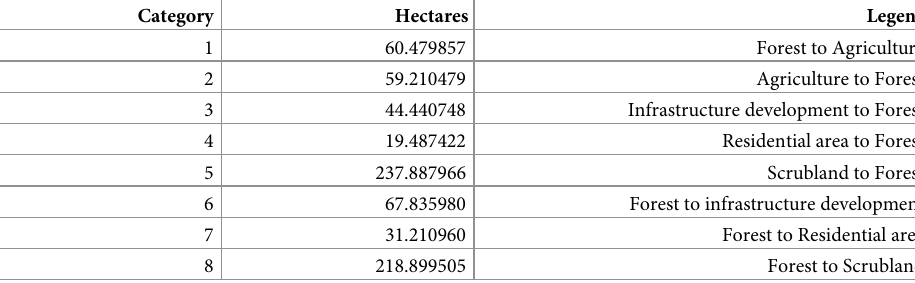
Table 9. LULC conversion between 2010 to